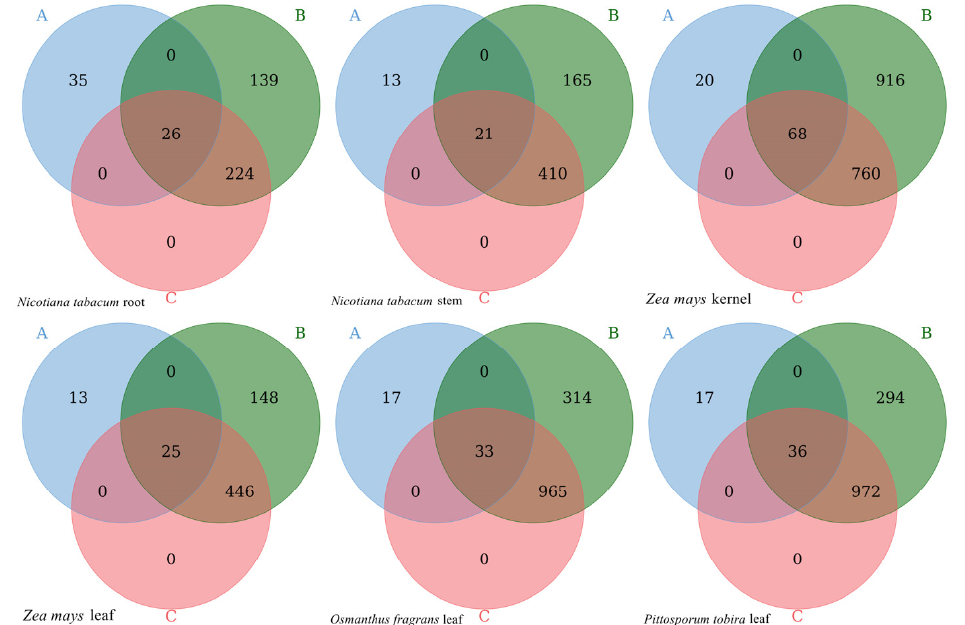
Figure 4. Venn diagram of the number of bacteria and microorganisms at the genus level with different methods. Note: A represents the number of bacterial genera obtained by the 16S amplicon sequencing method, B represents the number of all endophytic microbial genera obtained by the new analysis strategy, and C represents the number of bacterial genera obtained by the new analysis strategy. Venn diagram shows the distribution of the number of bacteria and microorganisms at the genus level with two methods, the overlapping parts represent common bacterial genus between A, B and C, while the non-overlapping parts represent unique bacterial genus.